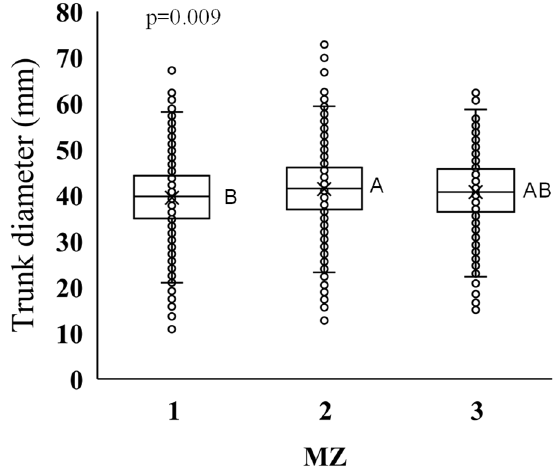
Figure 7. Boxplots presenting the distribution of trunk diameter of vines in the three management zones (MZs), as measured in January 2017. Different letters indicate significant differences as analyzed by ANOVA ( α = 0.05).